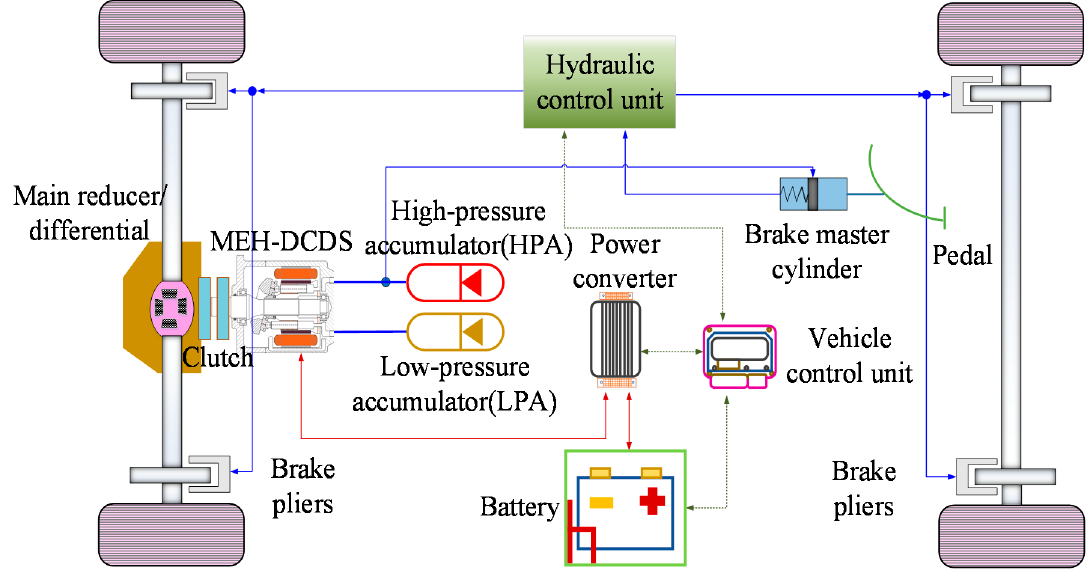
Figure 1. Structure of the mechanical–electric–hydraulic dynamic coupling drive system (MEH- DCDS).